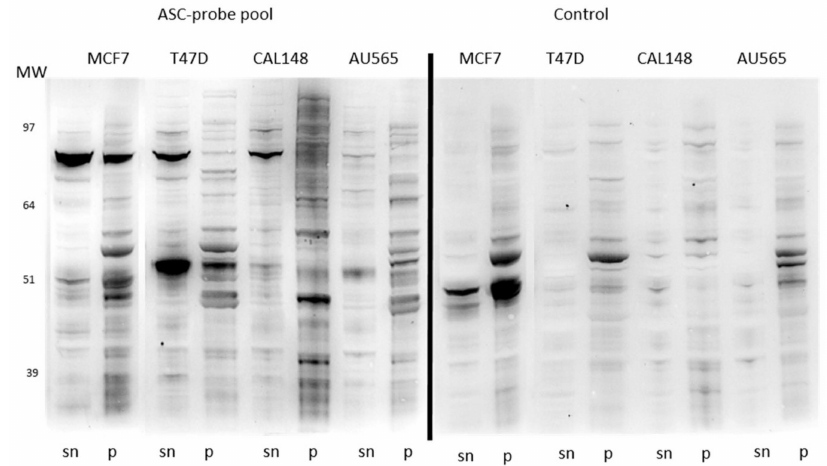
Figure 2. 1D Western blots of soluble (sn) and insoluble (p) extracts of di ff erent cancer cell lines screened with a pool of antibody-secreting cell (ASC)-probes ( left panel ) or control serum ( right panel